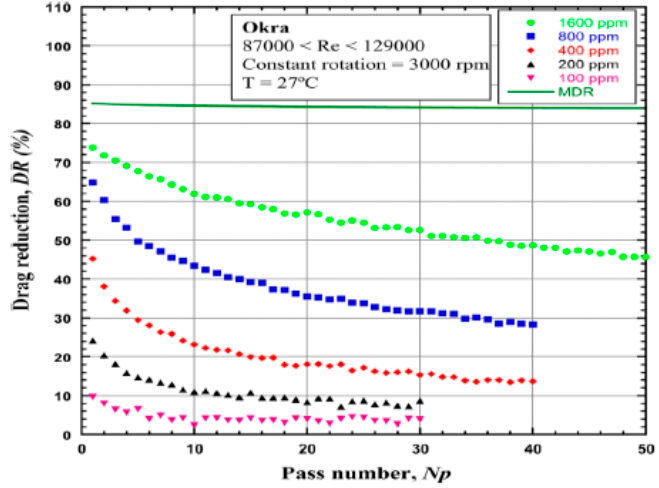
Figure 16. Drag reduction as a function of the number of passes through the system for a range of concentrations), reprinted with permission from [98]. Copyright Springer, 2016.